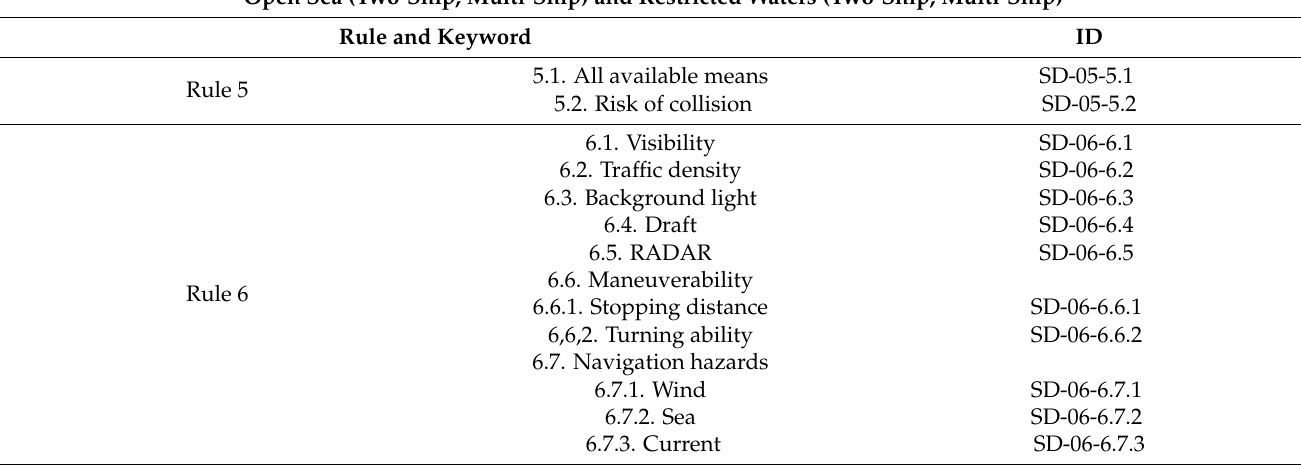
Table A5. Requirements specifications for ship